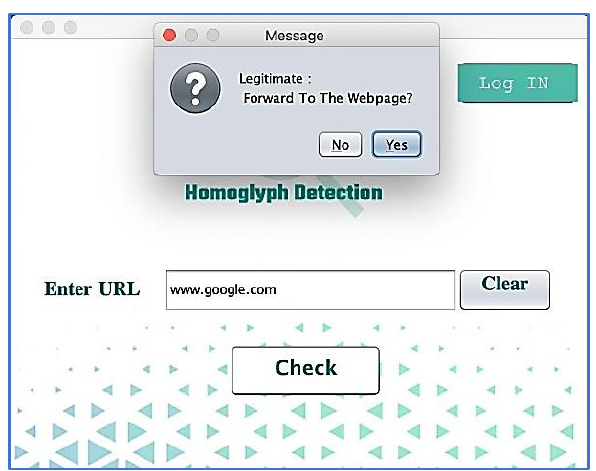
Figure 8. Legitimate